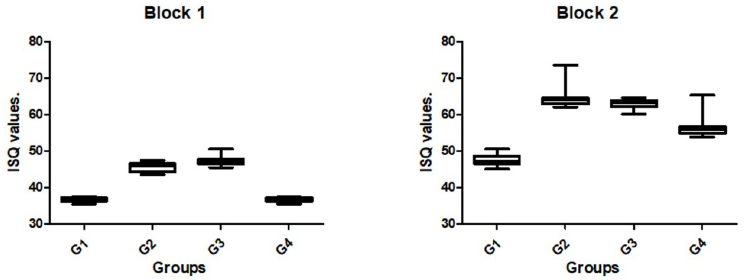
Fig 5. Box plot graphs of ISQ data for each group in both synthetic bone blocks used (blocks 1 and 2).